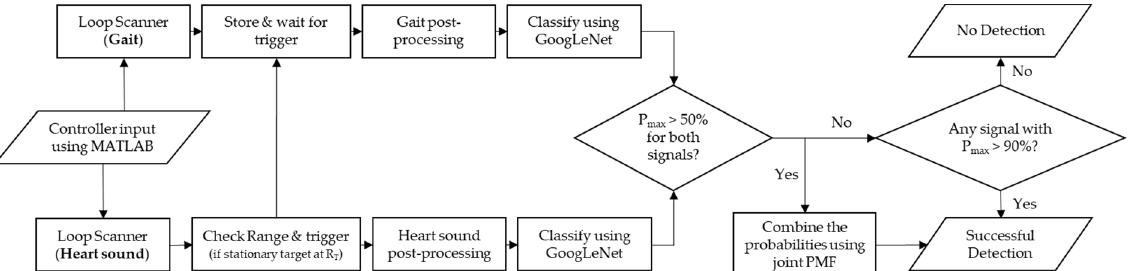
Figure 9. The signal processing pipeline used in the practical testing to classify the subjects and validate the data.